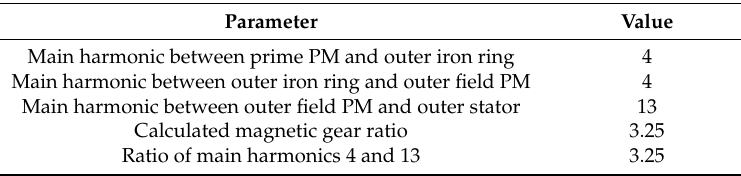
Table 4. Outer air-gap flux density performance of the magnetic gear.